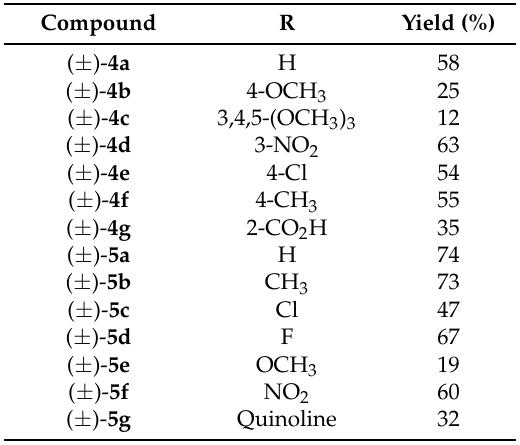
Table 1. Product yields for compounds 4a – g and 5a – g .